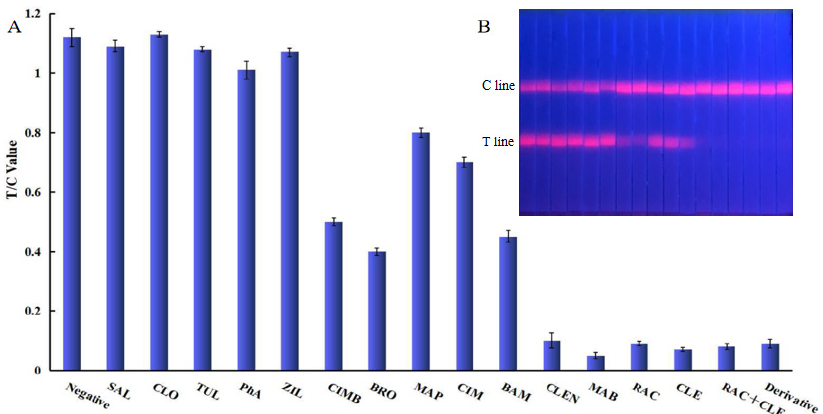
Figure 3. Specific analysis of EuNP-FLFIA. ( A ) Specific evaluation results (from left to right are negative: SAL, CLO, TUL, PhA, ZIL, CIMB, BRO, MAP, CIM, BAM, CLEN, MAB, RAC, CLE, RAC+CLE, and Derivative). ( B ) T/C value data analysis showing the extent of the cross-reactivity of CLE-RAC with other β 2 -agonists.